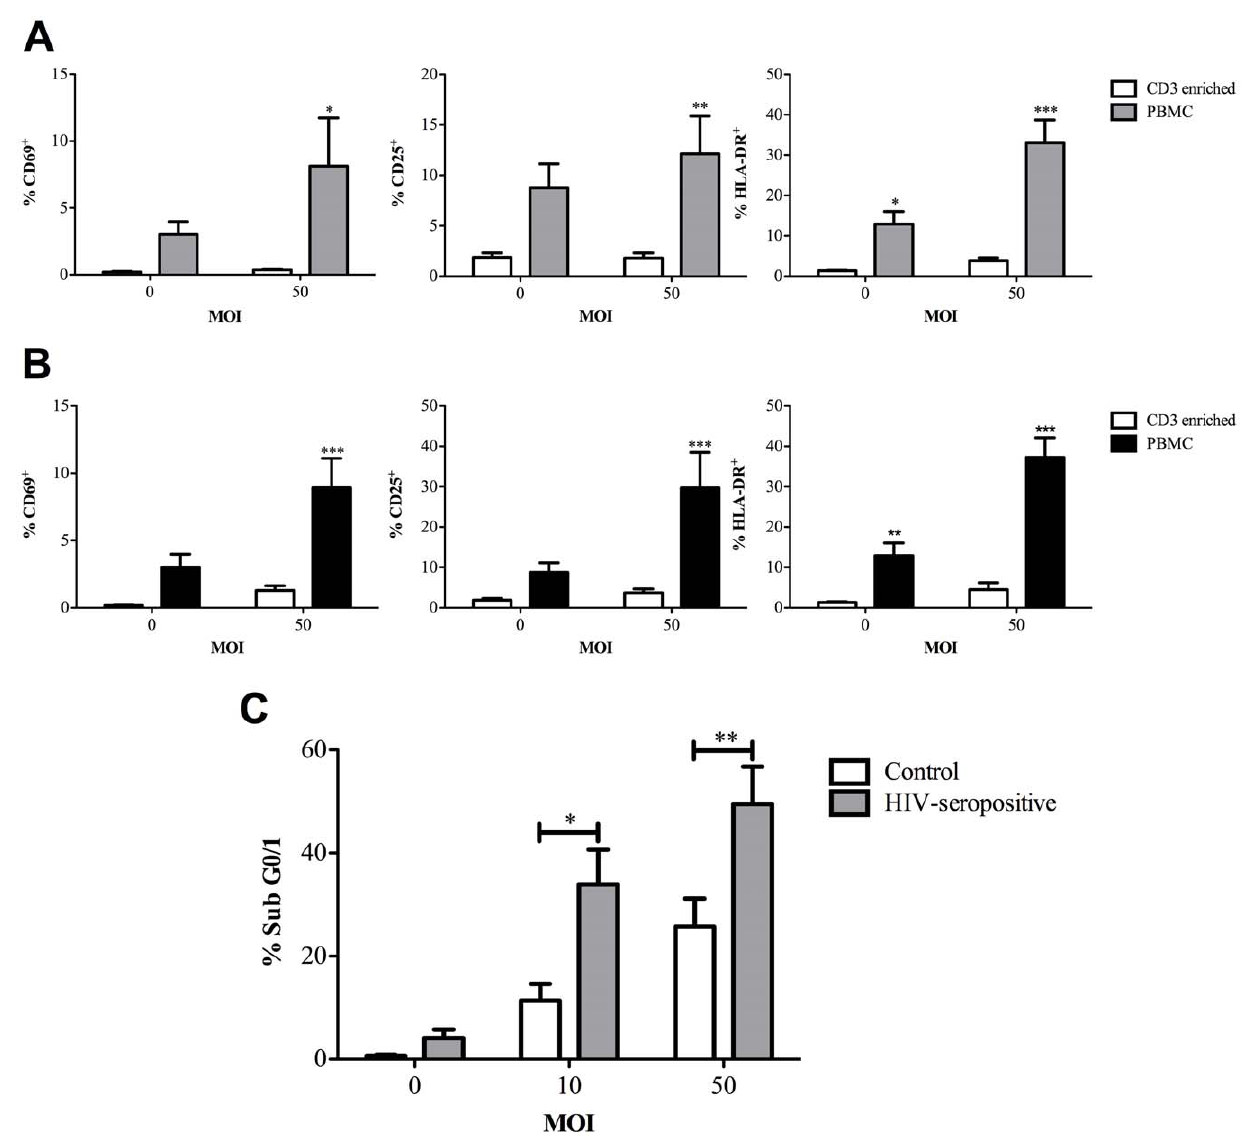
Figure 5. Monocytes enhance CD3 + T-cell activation following bacterial challenge and enhanced activation increases apoptosis. The percentage of CD3 + T-cells positive for CD69, CD25 and HLA-DR in highly purified CD3 + T-cells (CD3 enriched) or peripheral blood mononuclear cells (PBMC) following either mock-infection (multiplicity of infection (MOI)=0) or challenge with A) live Streptococcus pneumoniae (MOI=50) for 16 h, n=8 or B) heat killed S. pneumoniae (MOI=50) for 72 h, n=4, * p , 0.05, ** p , 0.01, *** p , 0.001; statistical analysis by ANOVA. C) The percentage of CD3 + T-cells with accumulation of hypodiploid DNA (Sub G0/1) 6 h following mock-infection (multiplicity of infection (MOI)=0) or challenge with Streptococcus pneumoniae (MOI=10 or 50) of peripheral blood mononuclear cells (PBMC) from control (n=6) or HIV-seropositive individuals, n=8, *p , 0.05, **p , 0.01; statistical analysis by ANOVA.